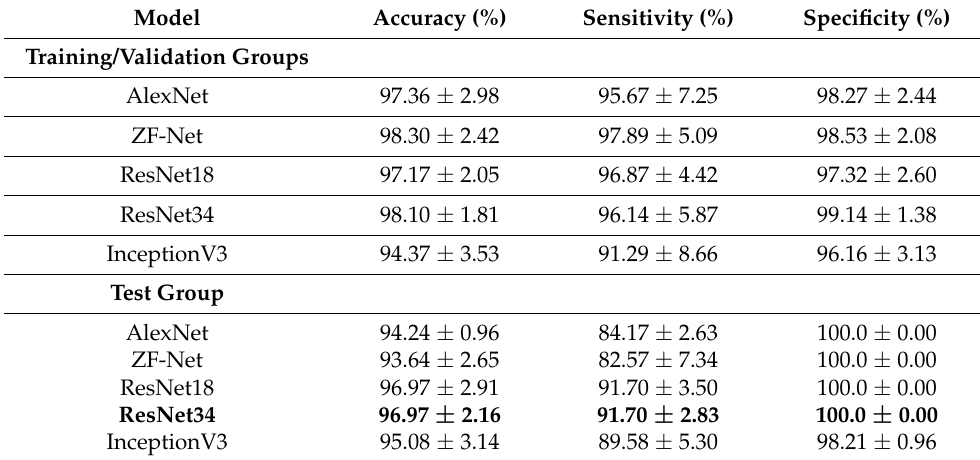
Table 4. Classification performance in NC vs.